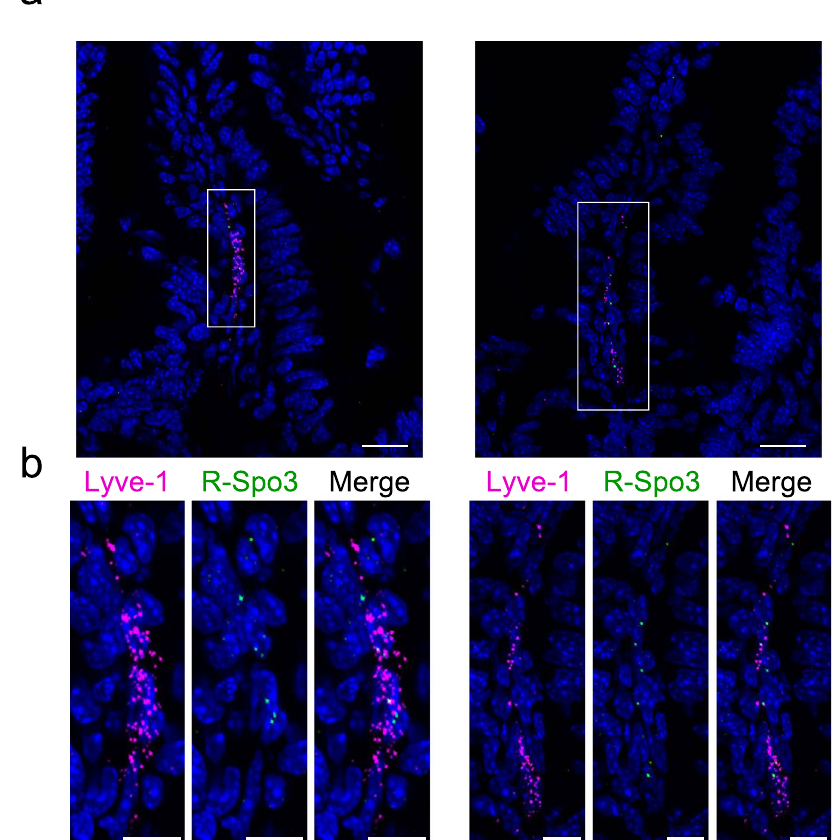
Figure 3. R-Spo3 transcription is detected in LECs by FISH. FISH was performed on the intestinal sections using fluorochrome-labeled probes against Lyve-1 (magenta) and R-Spo3 (green) mRNA. ( a ) Representative images from two different parts of the small intestine are shown. ( b ) Images of the Lyve-1 and R-Spo3 signals in the white rectangles on the top panels were magnified and presented as separated or merged images bellow the original